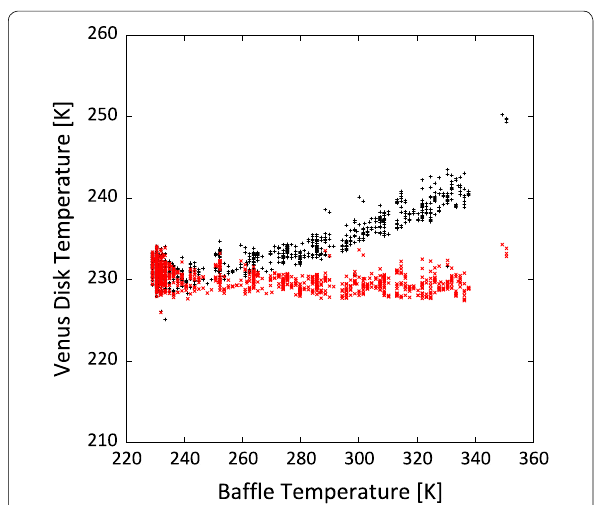
Fig. 7 Same as Fig. 6 but for temperature distributions at the center of the Venus disk